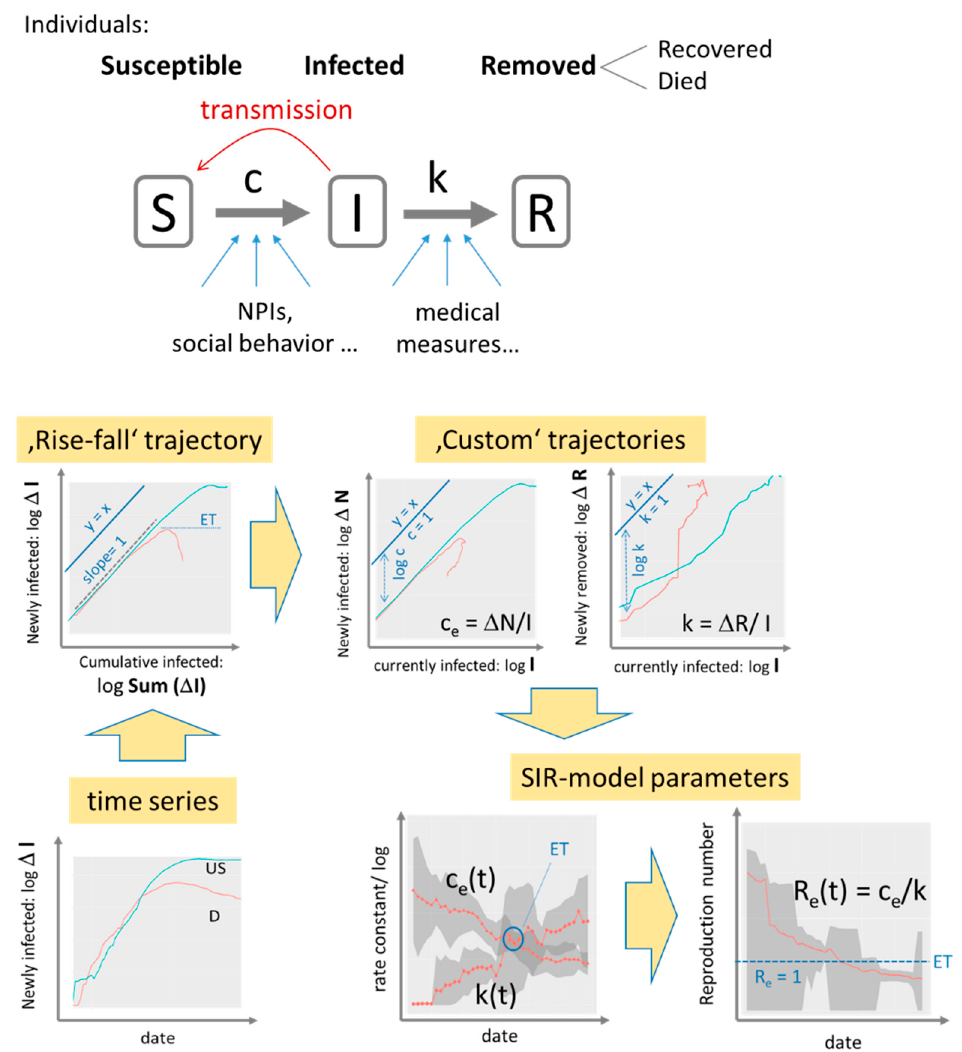
Figure 3. SIR model analysis: The SIR model assumes a sequence of three disease states (S, I, R, S + I + R = N, N population size) and transitions between them. Transmission and removal rates (numbers per day) are quantified in terms of the rate constants c and k, respectively. The time series of infected cases transforms into trajectories, which show daily changes of infected and removed cases as a function of cumulated or current infections in double logarithmic scale. Exponential growth is indicated by slope of unity while the transmission and removal rate factors refer to the vertical distance between the respective trajectory and the diagonal line (y = x). A downwards curved trajectory indicates decreased growth or eradication of epidemic (slope < 0) with the epidemic threshold (ET: slope = 0) indicating stop of epidemic. Values of the factors ce and k and of the reproduction number Re are plotted as a function of date as running averages over a sliding window of seven days (the running standard deviation is shown as grey uncertainty strip). Example data are shown for Covid-19 case numbers in Germany (D, red curves) and USA (US, blue) from 27 April 2020. See text and Supplementary File, Appendix I and II for details.